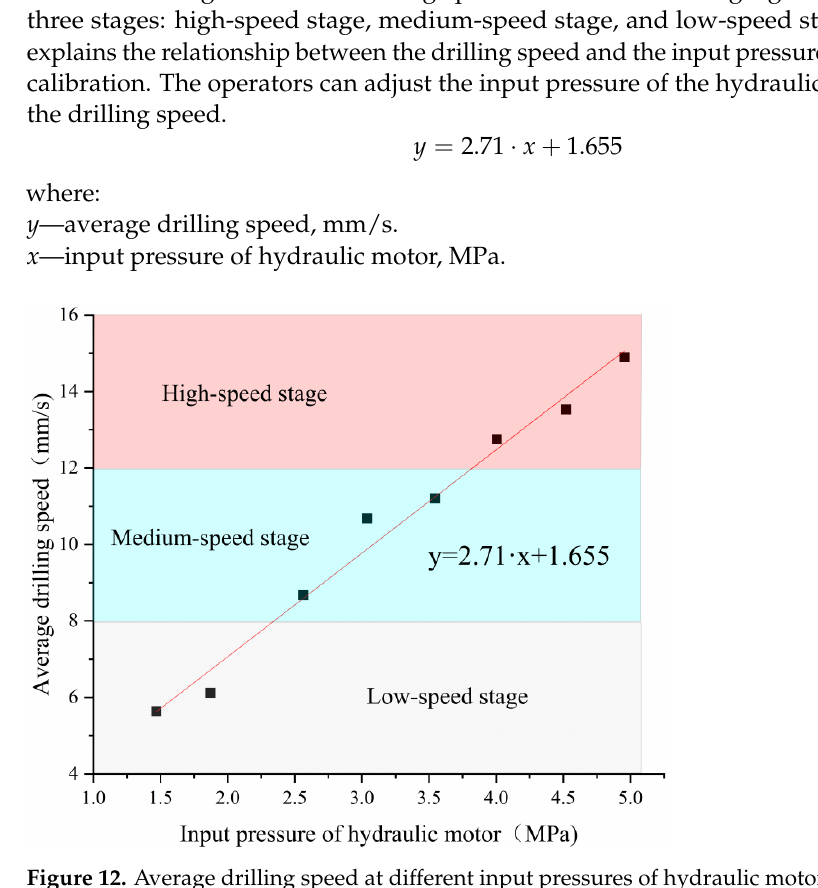
Figure 12. Average drilling speed at different input pressures of hydraulic motor.